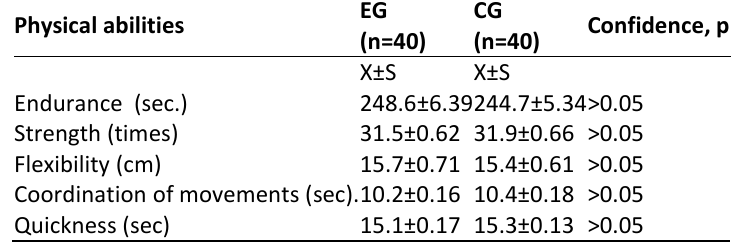
Table 2. Indicators of EG and CG students’ general physical fitness at the beginning of experiment (n =